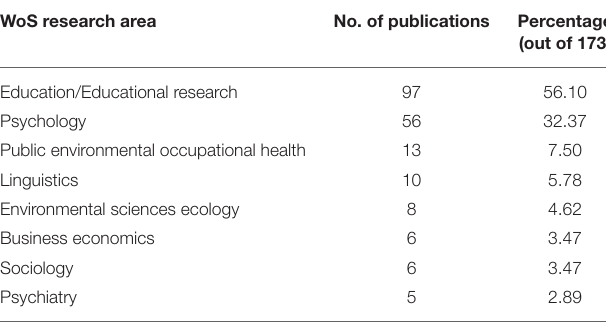
TABLE 3 | Distribution of TEL publications per WoS research